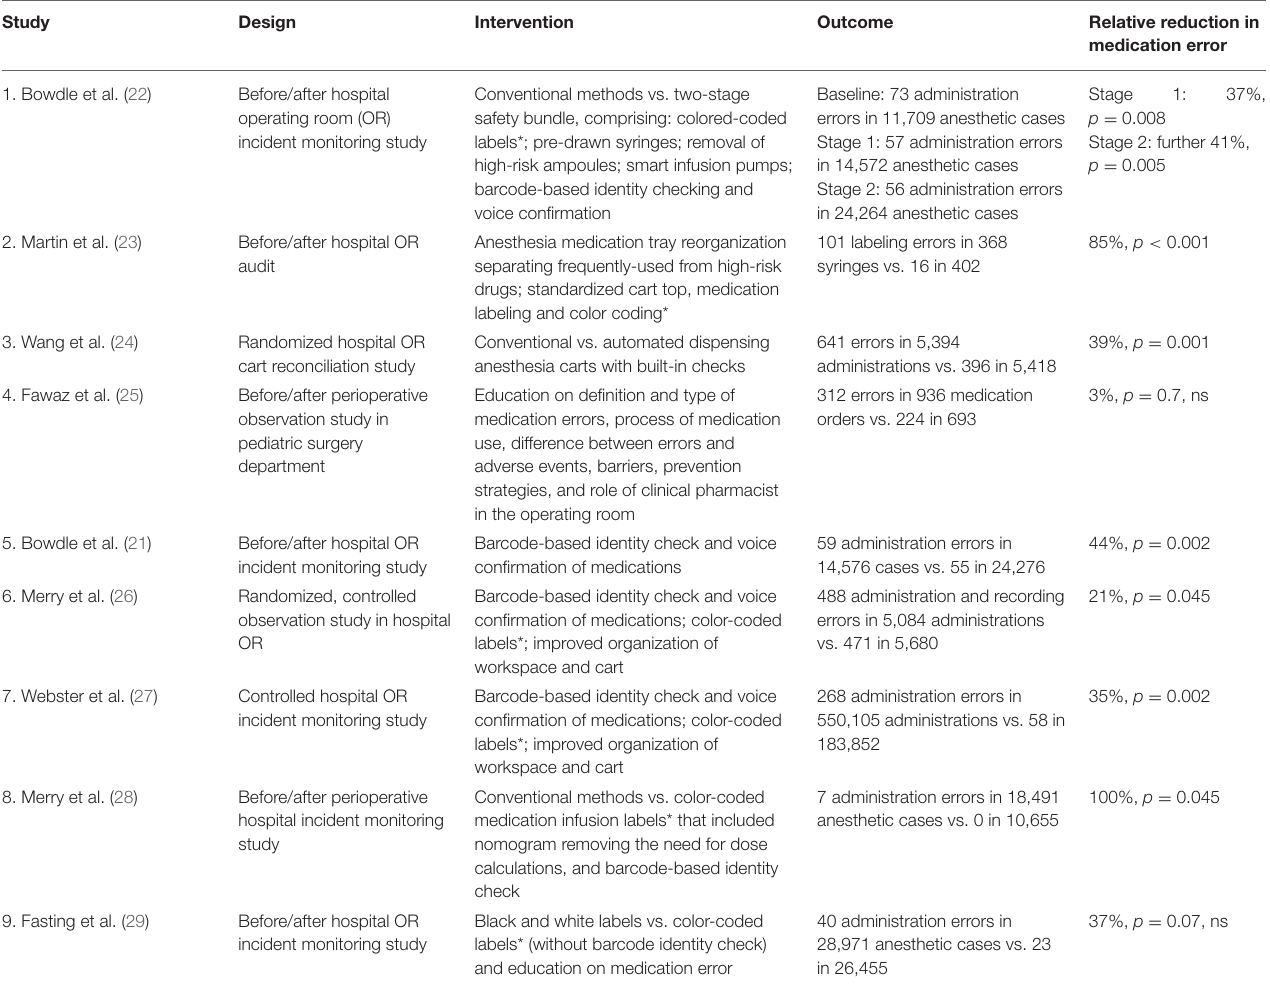
* Color coding according to the international color-code standard for anesthetic